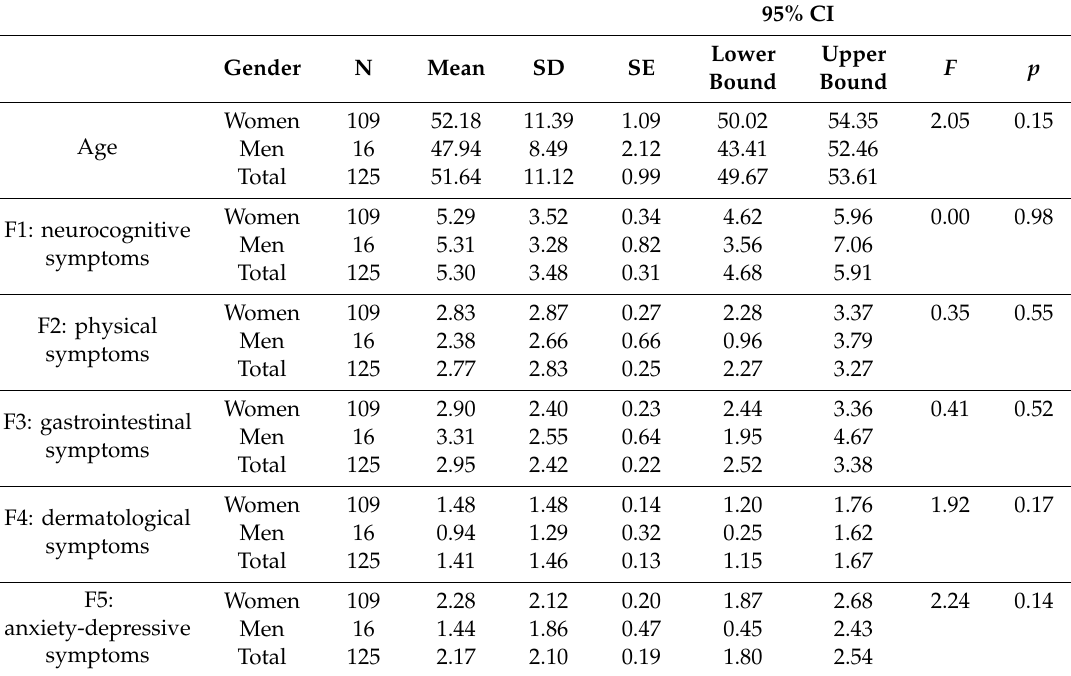
Table 4. Factor scores in gender subsamples (1-way